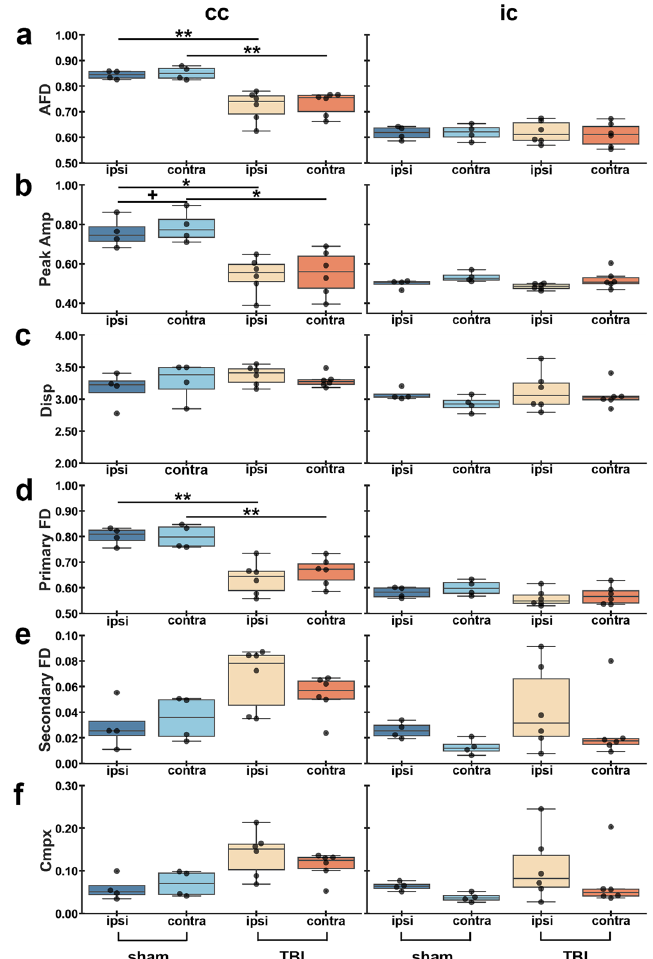
Figure 3. ROI-based analysis of fixel-based metrics in white matter areas. Results are shown as minimum, lower quartile, median, upper quartile and maximum, and paired t-test comparing ipsi- and contralateral sides within animals ( *q < 0.05, **q < 0.01) or unpaired t-test comparing the same hemisphere between sham-operated and TBI rats ( + q < 0.05) which are FDR corrected. Abbreviations: AFD, apparent fiber density; Amp,